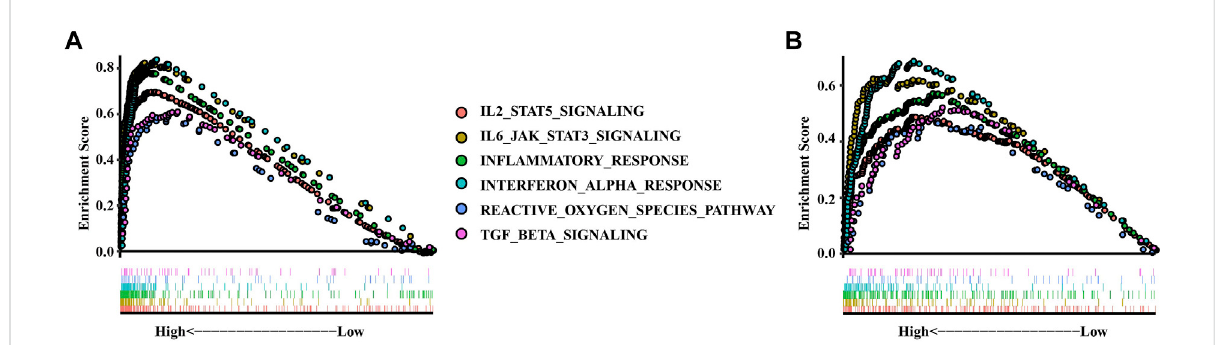
FIGURE 4 Related in fl ammatory pathways of siglec10 with GSEA analysis. (A) Related in fl ammatory pathways of siglec10 from TCGA dataset with GSEA analysis. (B) Related in fl ammatory pathways of siglec10 from the CGGA dataset with GSEA analysis.